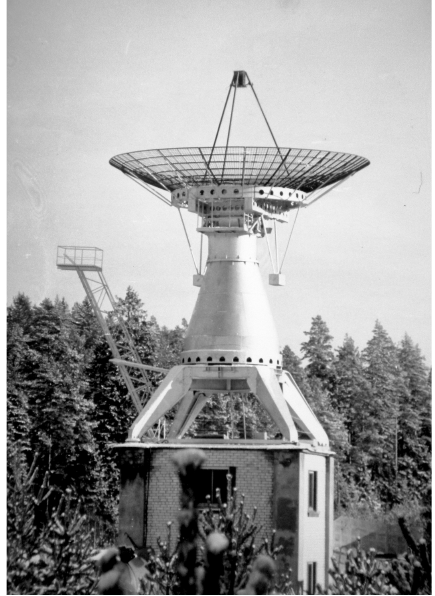
Fig. 1. Radio telescope RT-10 of the Bal- done Observatory. Photo by M.